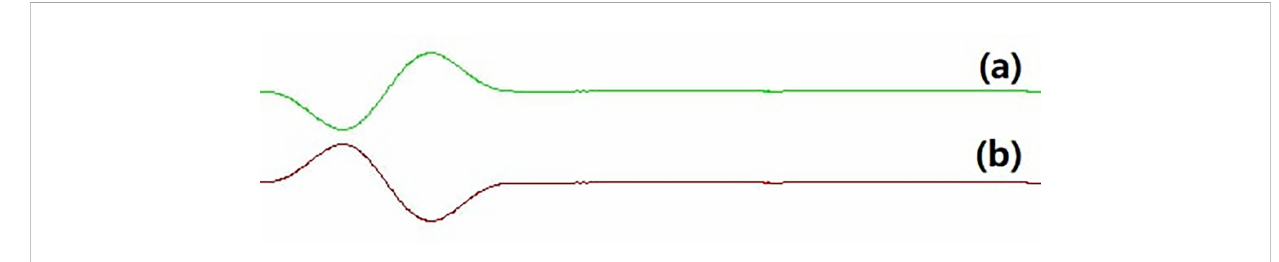
FIGURE 2 Opposite phase sound waveform. (A) the phase 90° sound waveform; (B) the phase 270° sound waveform.